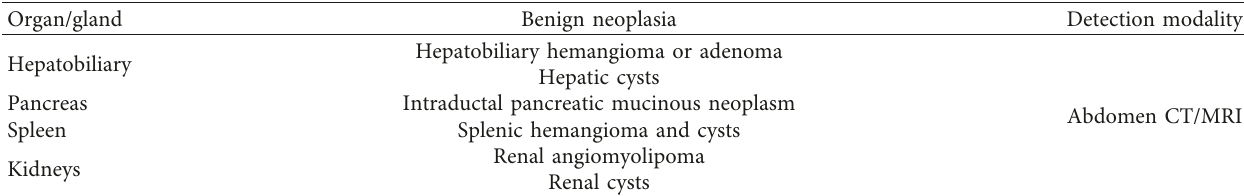
Table 1: Outcome assessments on abdominal cross-sectional imaging.